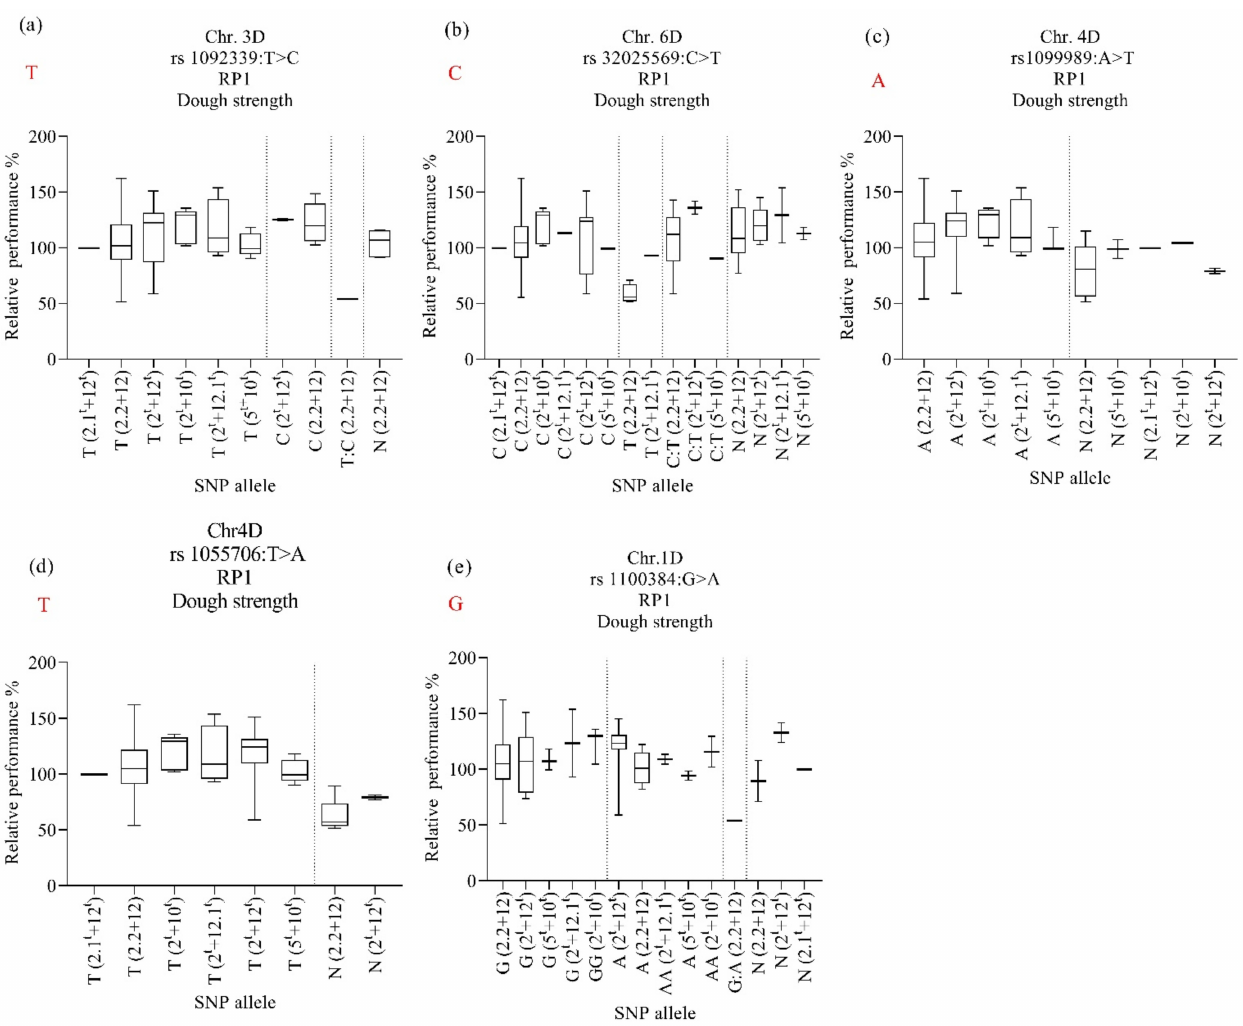
Figure 6. Effect of selected marker–trait associations ( a – e ) on relative performance of dough strength (PR1) in lines with different HMW-GS in MSD lines grown under heat stress conditions. A, adenine; C, cytosine; T, thymine; G, guanine; N, unknown. Alleles in red refer to those of the backcross parent of the population, ‘Norin